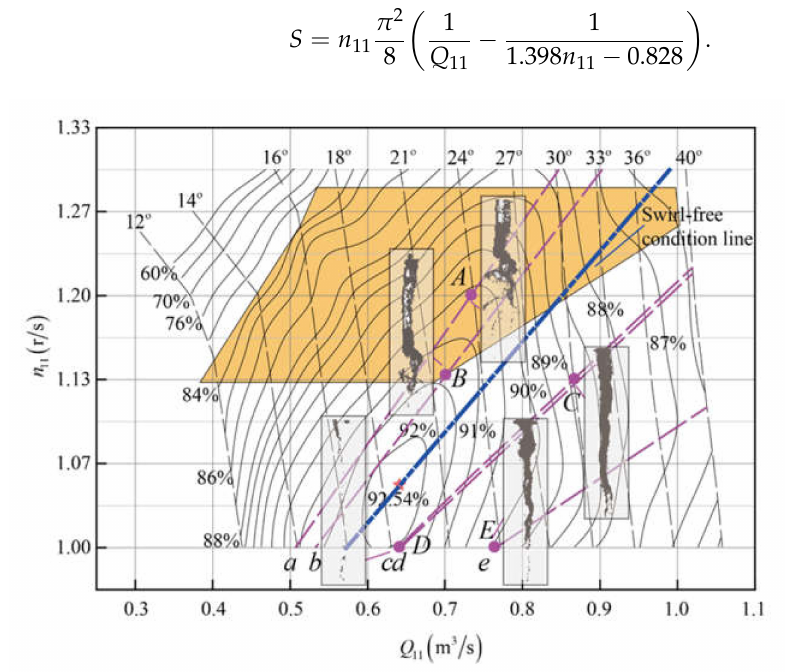
Figure 3. Hill diagram in unit parameters with 5 isolines of the swirl number. The letters A–E indicate the location of the studied regimes on the hill diagram according to Table 3. a ( S = 0.272); b ( S = 0.156); c ( S = − 0.237); d ( S = − 0.242); and e ( S = − 0.551). Table 3. Studied operating conditions